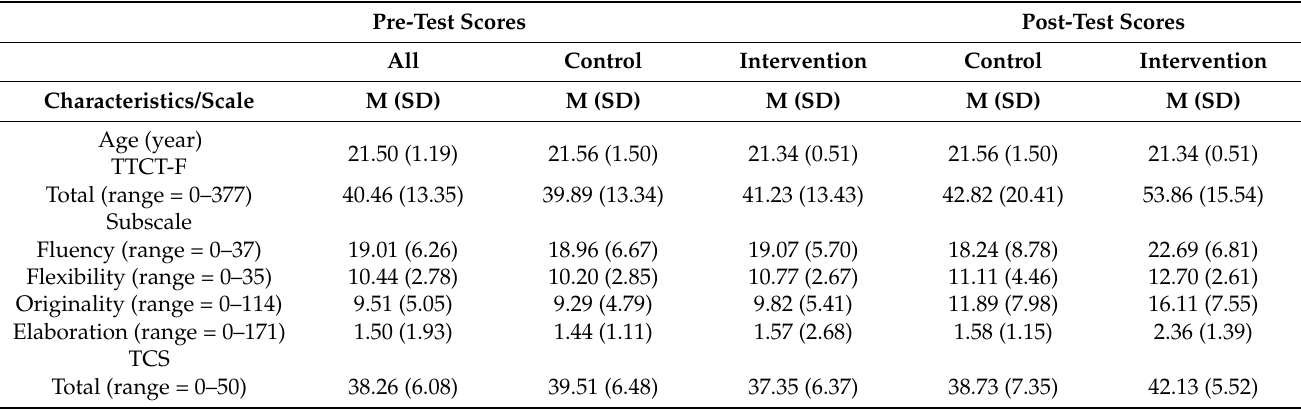
Table 3. Characteristics, Mean Scale, and Subscale Scores for Nursing Students in the Control ( n = 84) and Intervention Group ( n = 61).